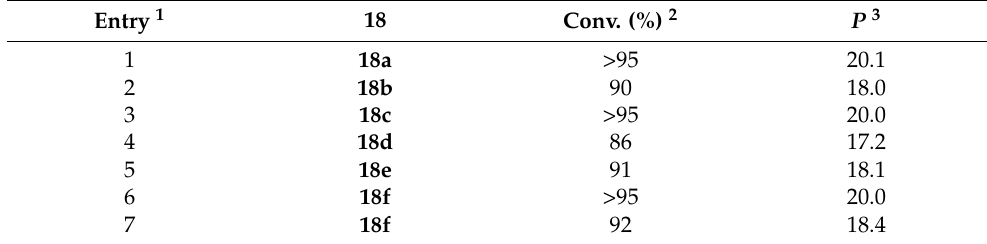
Table 4. Production of cyclic carbonates 18 under segmented flow conditions.